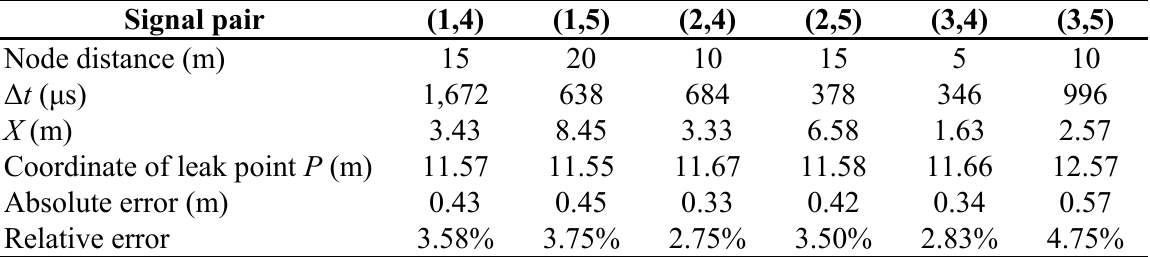
Table 4. Localization result and error of each pair of